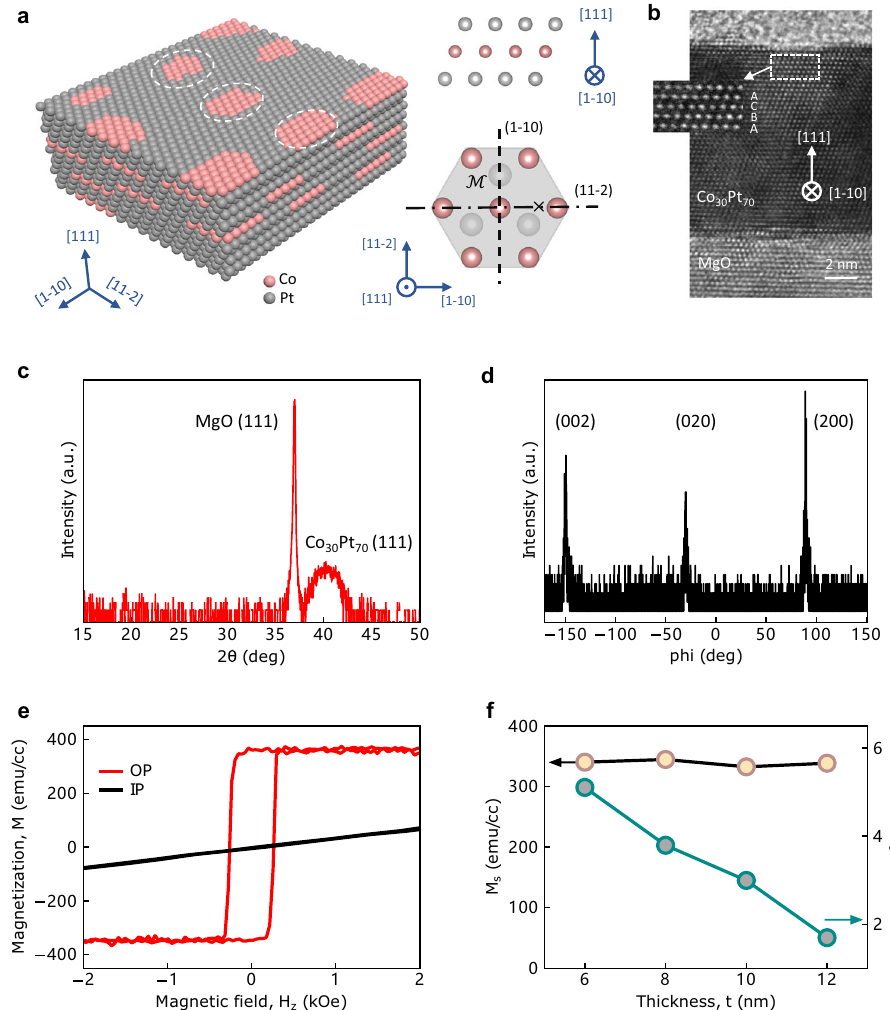
Fig. 1 Structural and magnetic properties of Co 30 Pt 70 thin fi lm. a Left: the schematic illustration of Co 30 Pt 70 with randomly located Co platelets (see white circles); right top: the side view of the Co platelet/Pt structure; right bottom, the mirror symmetry analysis of Co platelet/Pt, where [1-10] is de fi ned as the low-symmetry axis and [11-2] as the high-symmetry axis, respectively. b High-resolution transmission electron microscopy (HR-TEM) image of Co 30 Pt 70 with [1-10] pointing inward. The area within the dotted rectangle was ampli fi ed to present the stacking sequence (ABCABC … , from bottom to top) of Co 30 Pt 70 . c High-resolution X-ray diffraction (HR-XRD) pattern of Co 30 Pt 70 . d HR-XRD phi-scan pattern with Co 30 Pt 70 (002) plane rotated along [111] axis. e Out-of-plane (OP) and in-plane (IP) magnetic hysteresis loops of the unpatterned Co 30 Pt 70 thin fi lm. f Thickness dependence of the saturation magnetization ( M s ) and effective perpendicular magnetic anisotropy energy ( K eff